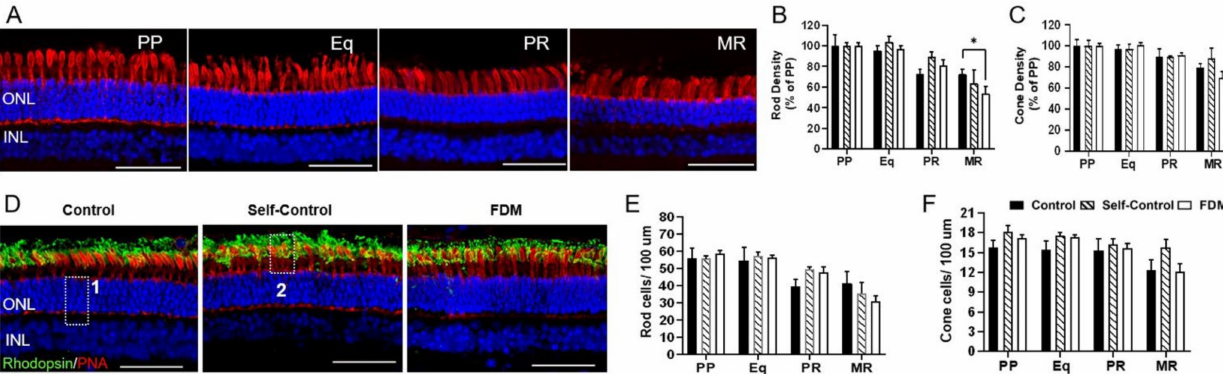
Figure 2. Photoreceptors in different groups of retinas. ( A ) Representative confocal images taken from the posterior pole (PP), equator (Eq), peripheral retina (PR) and marginal retina (MR) of peanut agglutinin (PNA)-labelled naïve control eye. Nuclei were stained with DAPI (blue). ( B , C ) The density of rod ( B ) and cone ( C ) expressed as % of PP in different retinal locations in naïve control, self-control and FDM eyes. ( D ) Representative confocal images of PNA (red) and rhodopsin (green) and DAPI labelled retinas from PP of naïve control, self-control and FDM eyes. Box 1 showing the counting of total number of photoreceptor nuclei; box 2 showing the counting of PNA + cone cells. ( E , F ) The number of rod cells ( E ) and cone cells ( F ) in different retinal locations of naïve control, self-control and FDM eyes. ONL, outer nuclear layer; INL, inner nuclear layer. Scale Bar: 50 µ m. Mean ± SD, n = 3~9/group. * p < 0.05. Two-way ANOVA followed by Fisher’s LSD